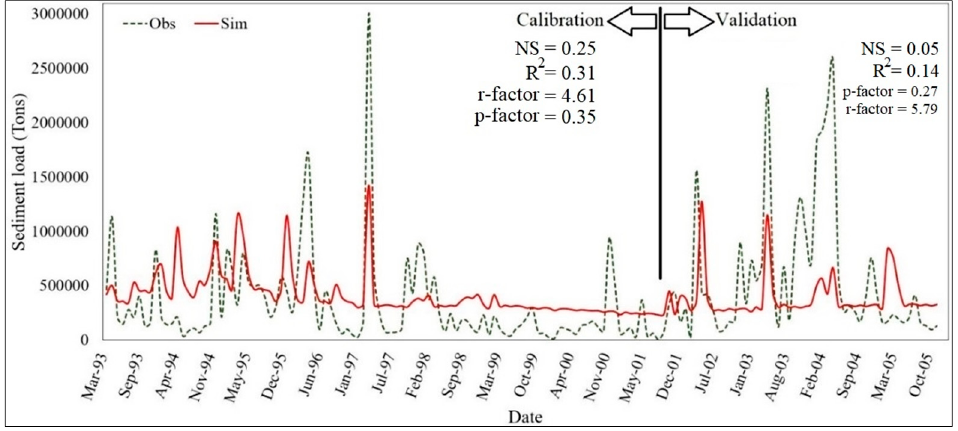
Figure 6. Calibration and validation of monthly sediment load in Dezful station (2012–2013).